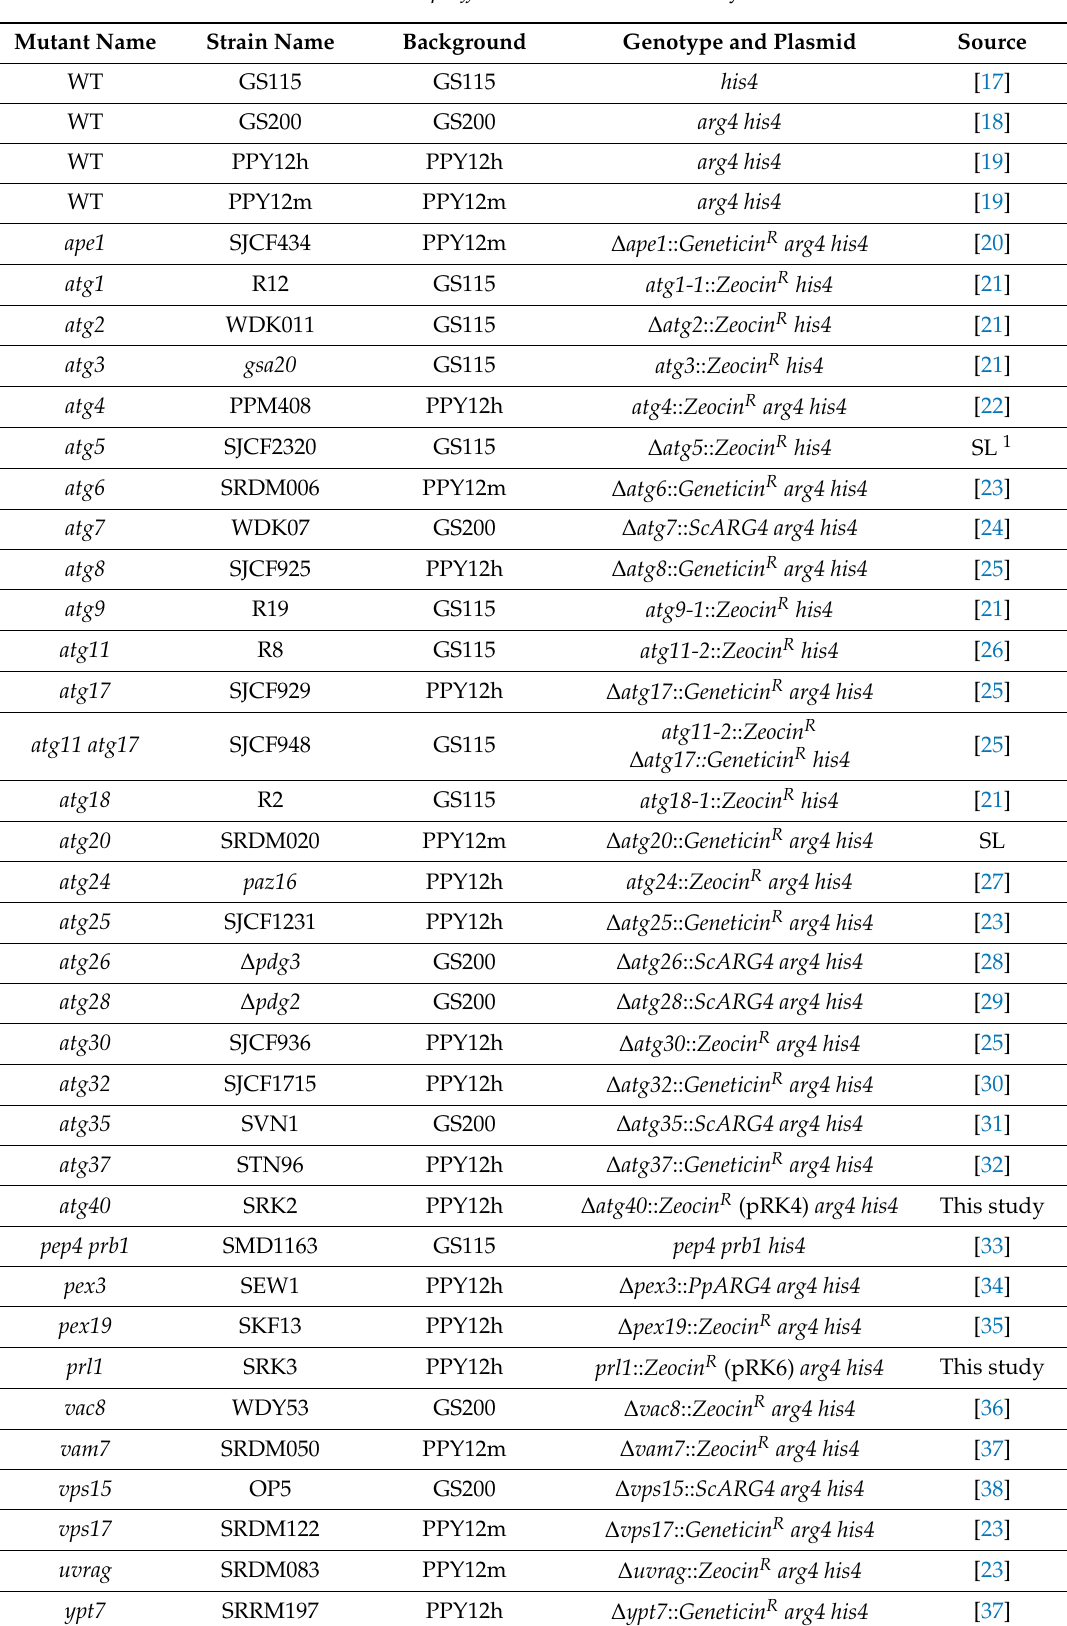
Table 1. K. pha ffi i strains used in this